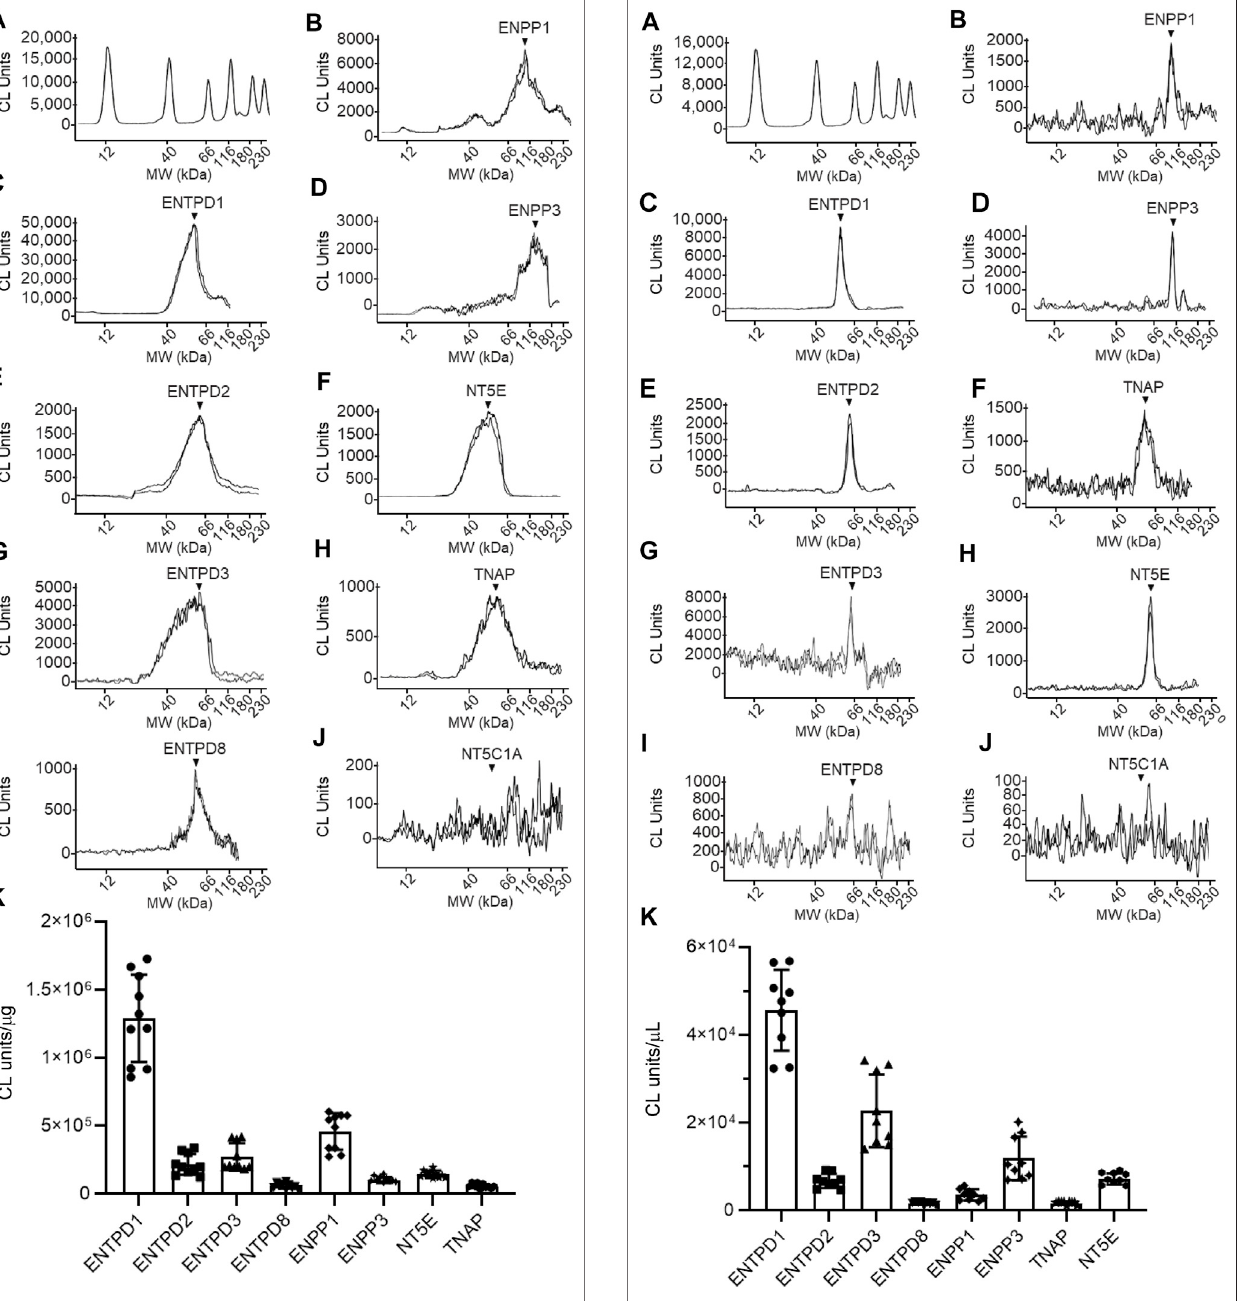
FIGURE11 | Protein expression levels in cELS collected from distended detrusor-free bladder preparations. Representative immunoelectropherograms (duplicates) of nucleotidases detected in cELS using ProteinSimpleWes (A – J) .Each antibodywasdiluted100-fold and eachwellcontained3 µlofcELSsample.Theantibodiesusedaredescribedin Figure 9 and in main text Antibodies. (K) Scatter plots of AUC of chemiluminescence(CL)signalsnormalizedperµLloadedcELSsample.Each symbolrepresents asingle loadingfrom3cELSsamples,loaded intriplicates. Statistical signi fi cance is described in main text